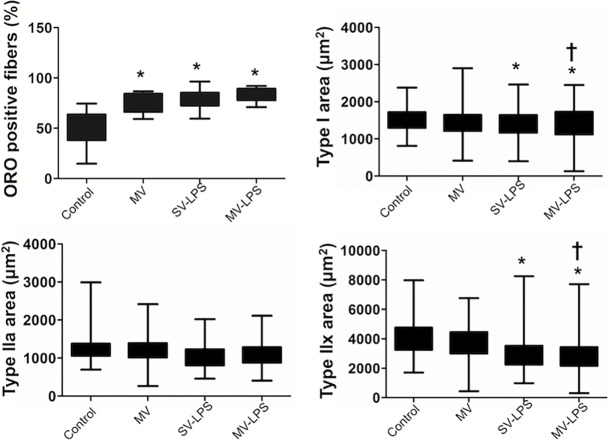
Proportion of diaphragm myofibers in which intramyocellular fat droplets was observed (panel A) and diaphragm cross-sectional area (CSA) of type I (panel B), type IIa, (panel C) and type IIx fibres (panel D) in the four experimental groups. ORO = Oil Red O; Control = spontaneous ventilation without endotoxemia; MV = mechanical ventilation without sepsis; SV-LPS = endotoxemia with spontaneous ventilation; MV-LPS = endotoxemia with mechanical ventilation. Results are presented in the form of box plots as well as individual values. Boxes are drawn between the first and third quartiles of the distribution, black bars indicate the median, and whiskers indicate the minimum and maximum values, n > 4 per group. *: P<0.05 versus Control; †: P<0.05 versus MV.